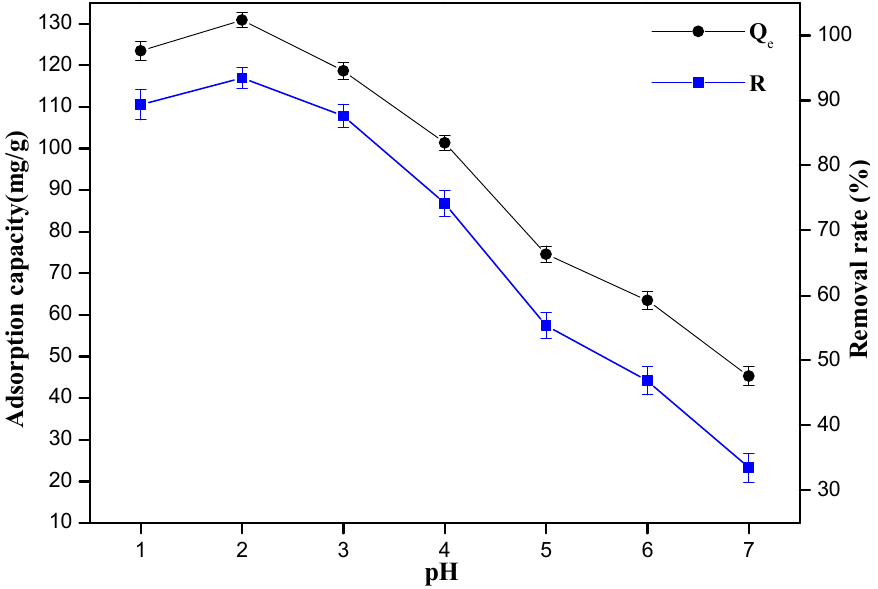
Figure 4. Effect of pH value on the sorption of Cr(VI) ions.